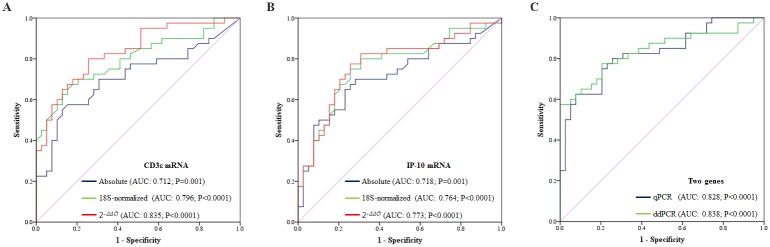
Comparison of several methods for mining data and two PCR platforms.(A-B) The area under the curve (AUC) values for urinary CD3ε and IP-10 mRNA levels normalized by the total RNA amount (absolute), absolute copy number of 18S rRNA, or the 2-ΔΔCт method in qPCR platform. (C) ROC curves for two-gene set (CD3ε and IP-10) normalized by absolute copy number of 18S rRNA in qPCR and ddPCR platforms.